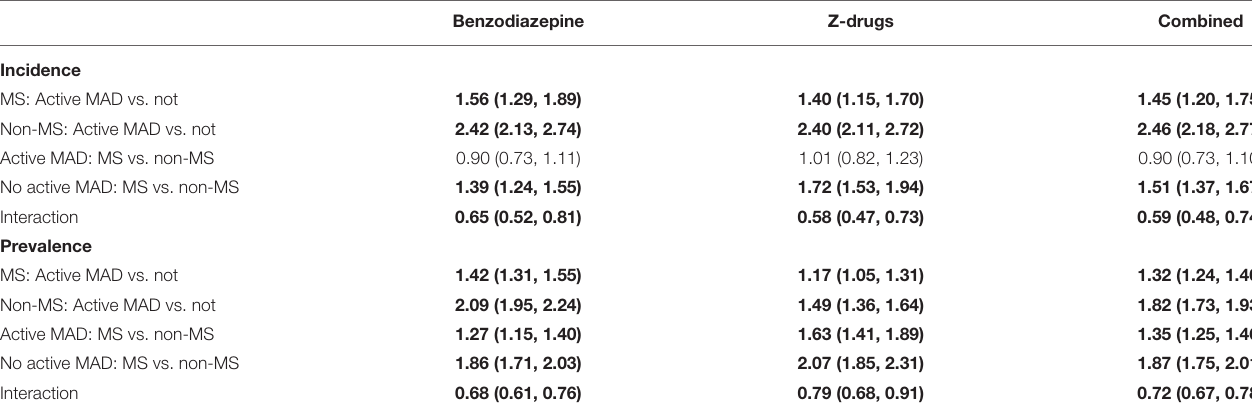
Benzodiazepine Z-drugs Combined